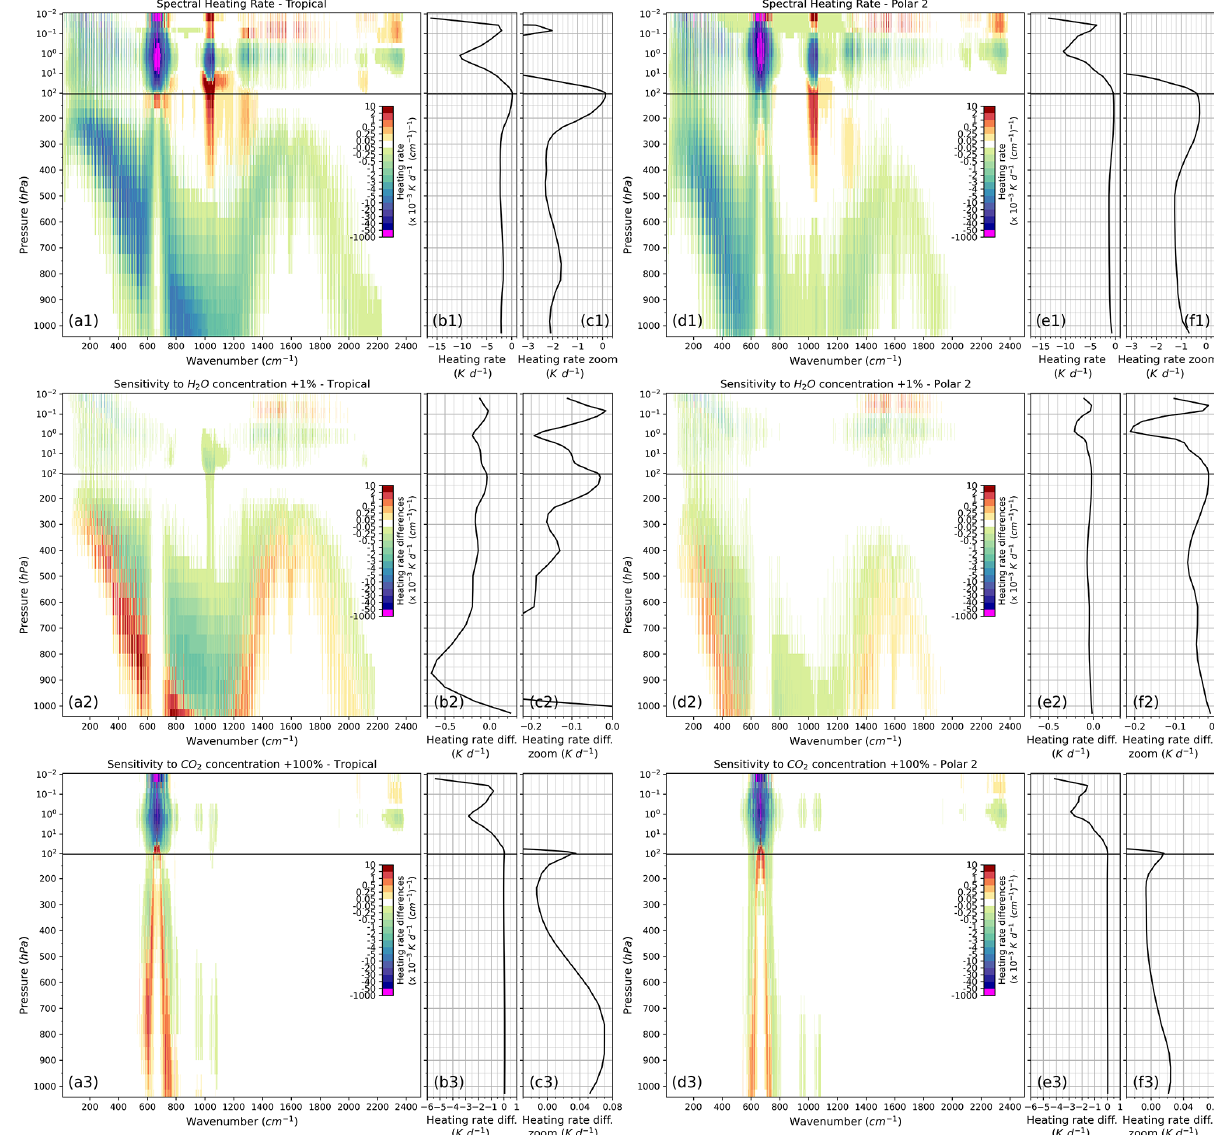
Figure 7. Top row (a1–f1) : vertical heating rate computed by 4A-Flux using TIGR mean Tropical (Polar 2) atmospheric situation in the left (right) panels. Panels (a1) and (d1) present the spectral heating rate profile as a function of the wavenumber and the pressure level. The heating rate profile integrated on the 10–2500cm − 1 spectral range is represented in panels (b1) and (e1) , and a focus on the tropospheric variations is displayed in panels (c1) and (f1) . Middle row (a2–f2) : vertical heating rate sensitivity to a 1% increase in H 2 O concentration. Panels (a2) and (d2) present the spectral heating rate sensitivity profiles [ H perturb. ( p ) − H ref. ( p ) ] as a function of the wavenumber (horizontal axis) and the pressure level (vertical axis). The heating rate sensitivity profile integrated on the 10–2500cm − 1 spectral range is represented in panels (b2) and (e2) , and a focus on the stratospheric variations is displayed in panels (c2) and (f2) . Bottom row (a3–f3) : analog to the middle row for a doubling of CO 2 concentration (instead of H 2 O). Panels (c3) and (f3) show a focus on the tropospheric